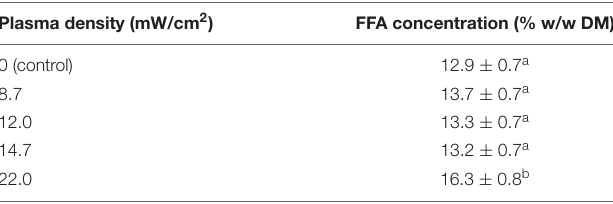
a , b Different superscript letters correspond to significantly different